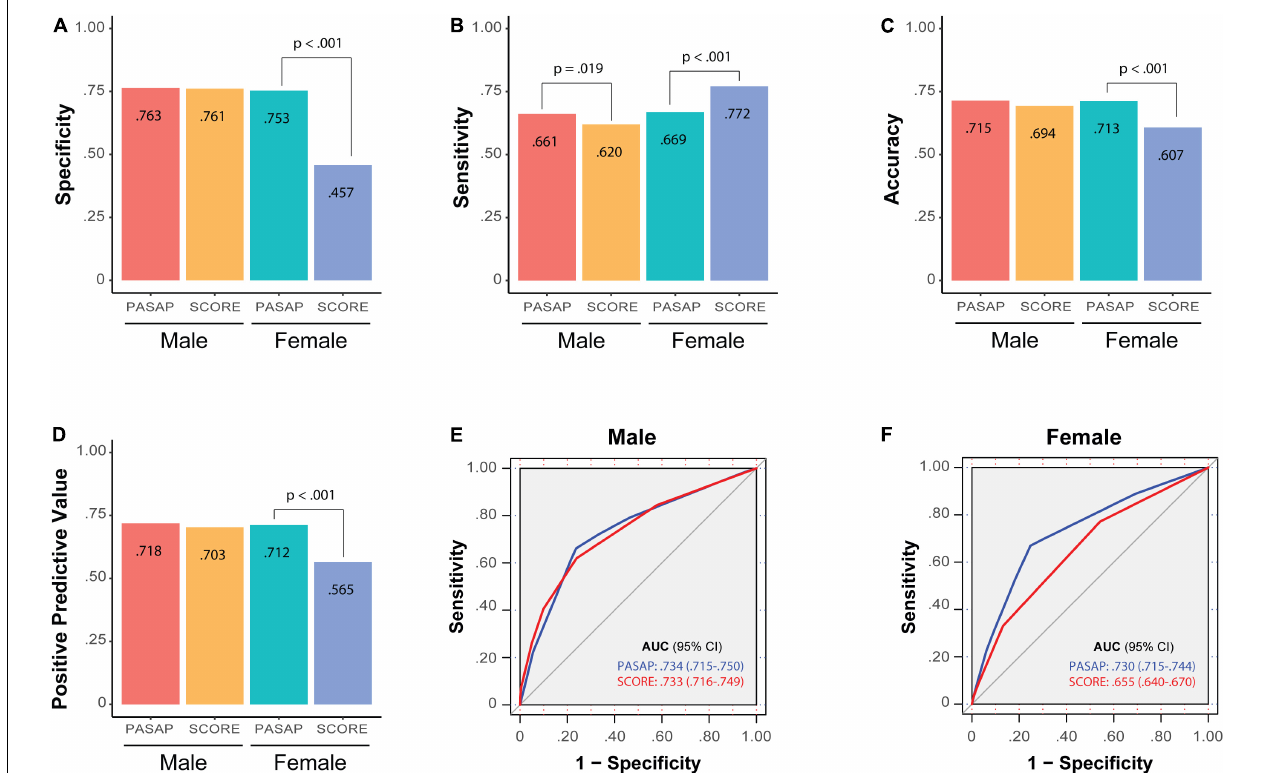
FIGURE 5 | Comparison of the PASAP-ILERVAS with the SCORE risk score. Barplots contain the main performance metrics of PASAP-ILERVAS and SCORE risk model in L&H-risk individuals: (A) specificity; (B) sensitivity; (C) accuracy; (D) positive predictive model; (E) ROC curve in men; (F) ROC curve in women. The ROC curves reflect the area under the curve between sensitivity and complementary of specificity with both models. SCORE, Systematic COronary risk Evaluation; ROC, Receiver Operating